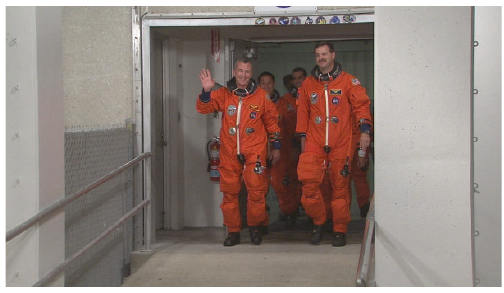
Figure 9: A picture from the “crew” test